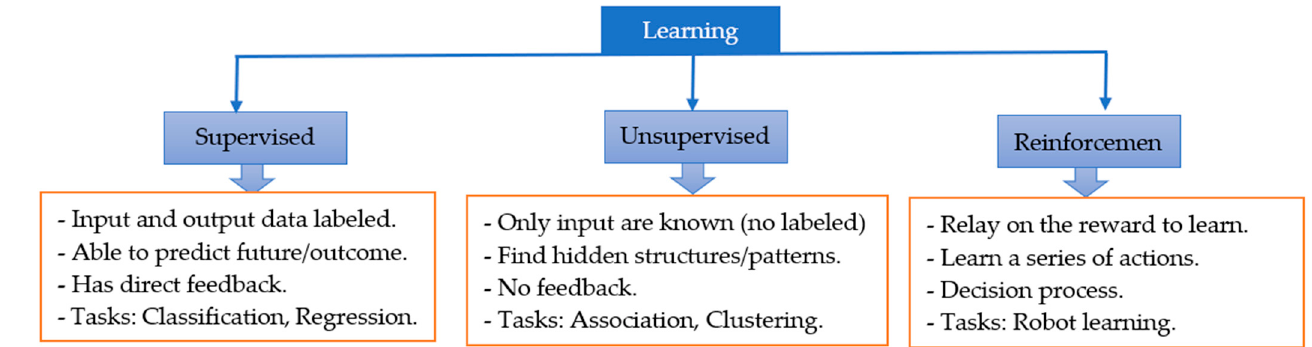
Figure 4. Machine learning categories.